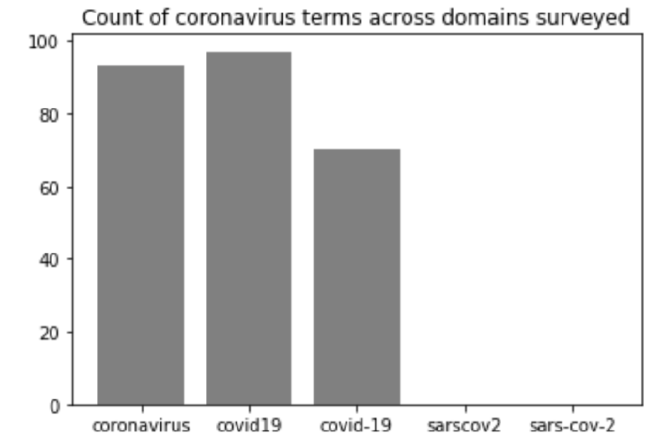
Figure 4. Distribution of recognizable terms across data